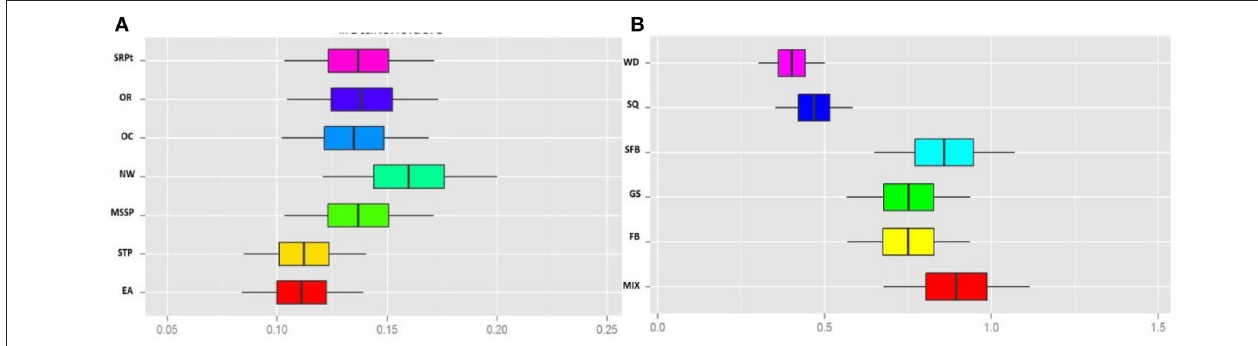
FIGURE 7 | Survey 2—NSFDSS (Ranking preferences): (A) ranking objectives and (B) management options, according to stakeholders’ preferences with uncertainty (box plot with median and percentile values: 0.05, 0.25, 0.75, and 0.95). (A) SRPt, Maintain a safe level of the reproductive potential of target species; OR, Optimize revenue; OC, Optimize costs; NW, Maintain occupation levels; MSSP, Maintain a safe structure of spawner population; STP, Maintain an adequate structure of target populations; EA, Allow equitable access to resources by all the fishing metiers. (B) WD, fleet withdrawal; SQ, keep the status quo; SFB, spatial fishing ban; GS, improve gears selectivity; FB, seasonal fishing ban; MIX, measures combination.